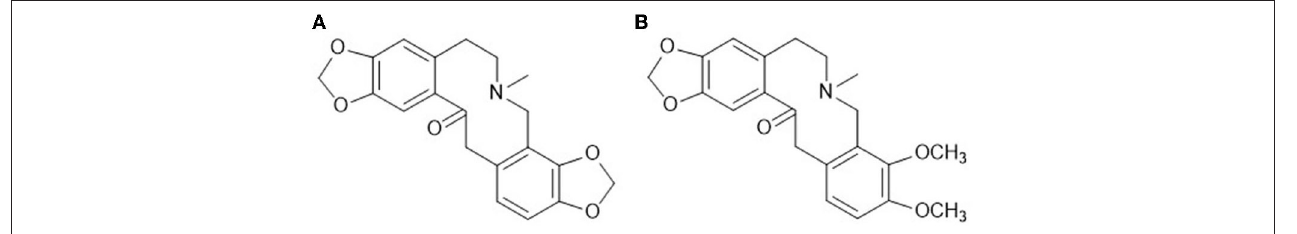
FIGURE 1 | Chemical structure formulas of the main components. (A) Protopine (PRO); (B) allocryptopine